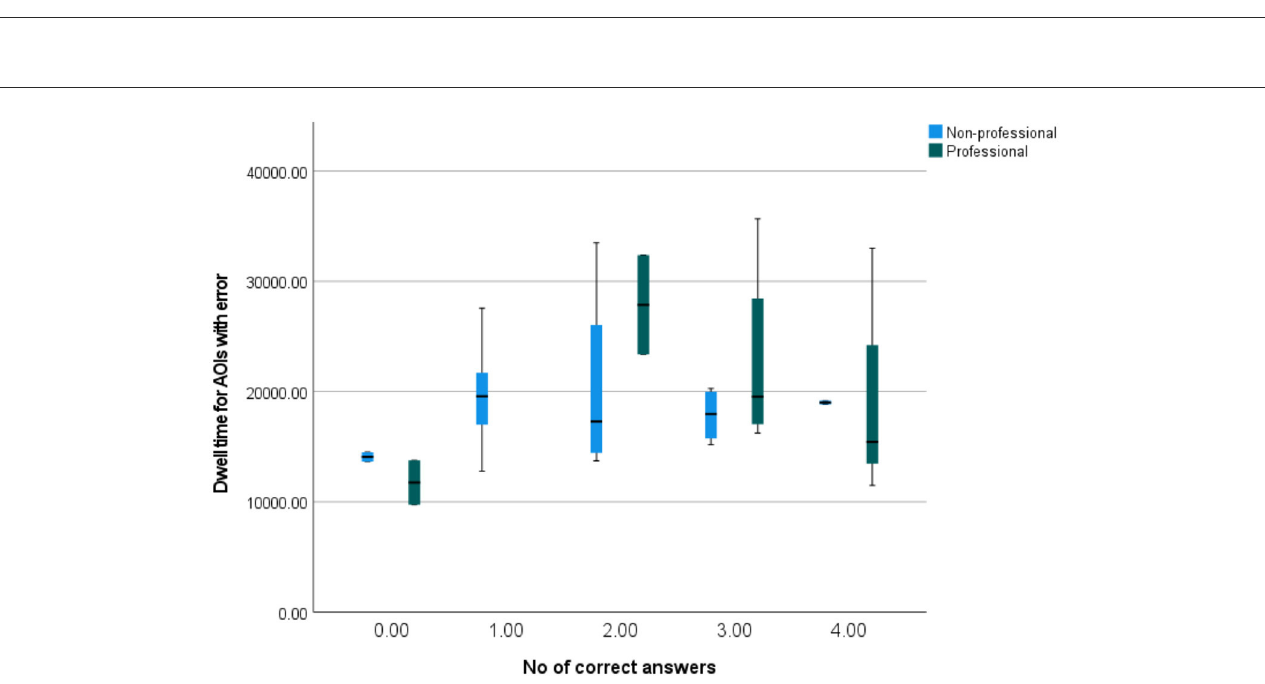
FIGURE14 A simple box plot of dwell times for AOIs with errors by the number of correctly answered